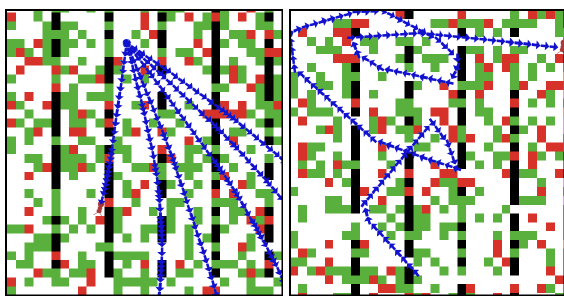
Figure 5: Short trajectories at the training phase. Insect collides and escapes the world repeatedly (left). Long tra- jectory shows insect avoiding red and black patches